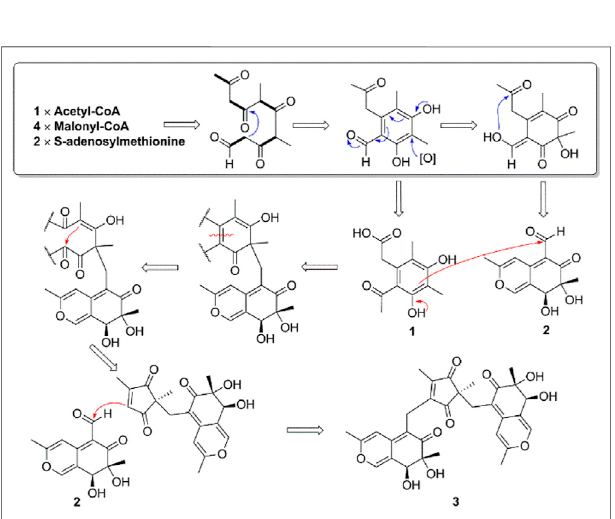
Scheme 2 | The Proposed Biosynthetic Pathway of Compounds 1 – 3